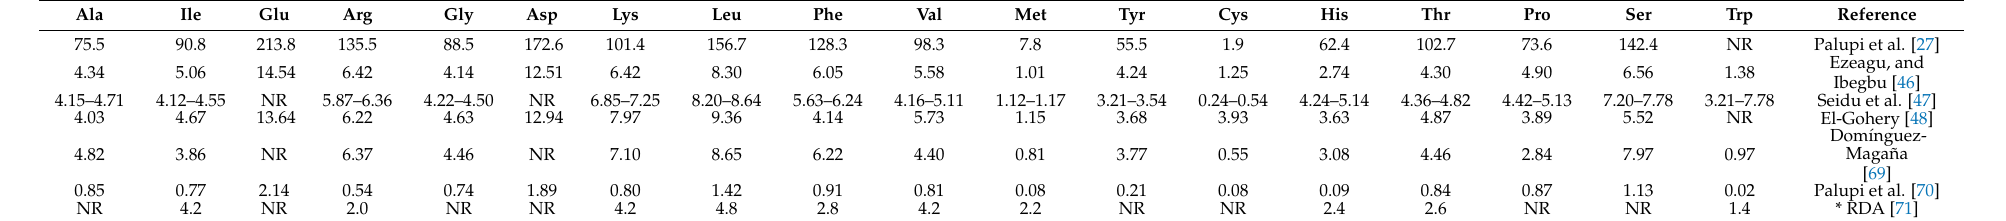
Table 2. Amino acid composition (g/100 g) of lima bean reported in